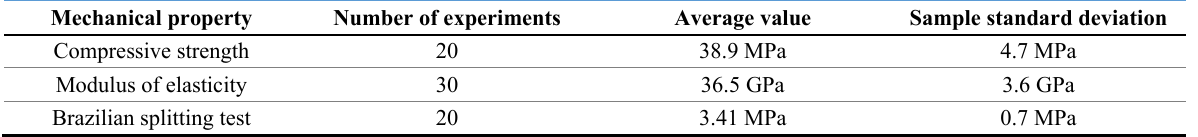
Table 1. Concrete material properties at 90 days.